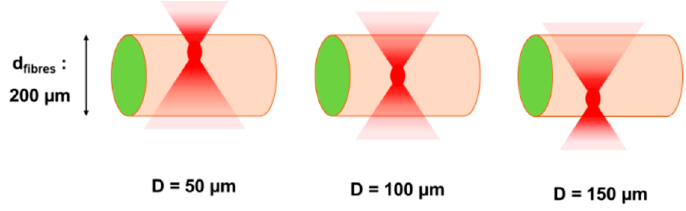
Figure 2. A schematic illustration of focal point positions for different depth of focus values inside a 200 μ m diameter microfibre. Red gradient cones map the laser fluence gradient before and after focalization. The further away from the focal volume, the lower the laser fluence.